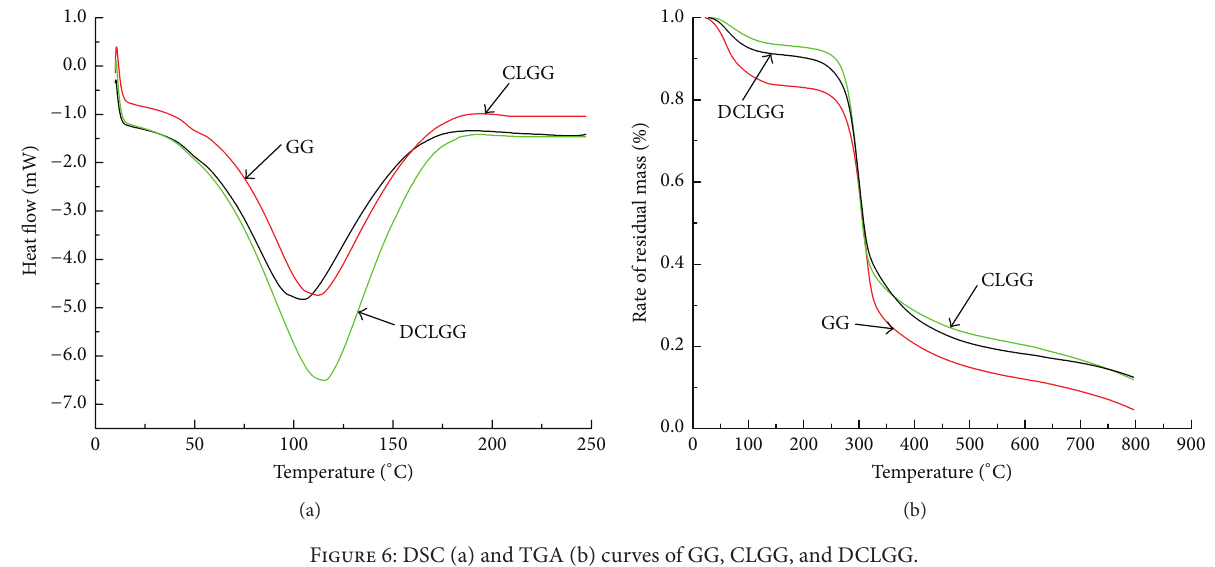
Figure 6: DSC (a) and TGA (b) curves of GG, CLGG, and DCLGG.